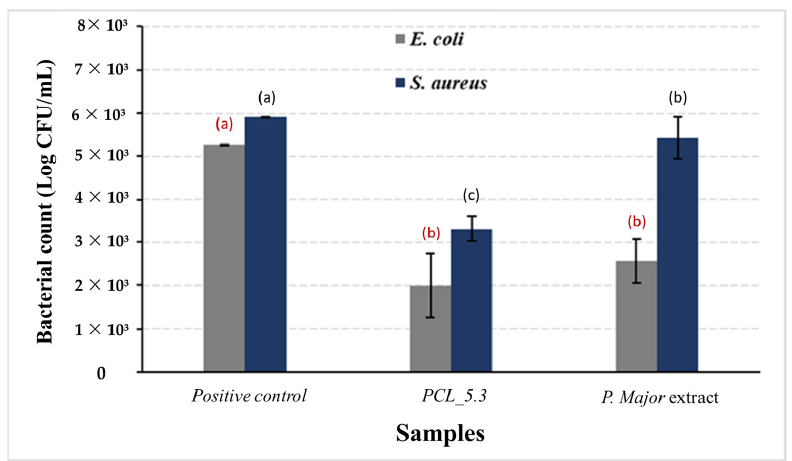
Figure 10. Antimicrobial activity of Plantago major hydroalcoholic extract and PCL/ P. major electrospun mat against E. coli and S. aureus strains. Pure PCL electrospun mat (PCL_0.0) was used as positive control (a,b,c Di ff erent le tt ers indicate statistically di ff erences (Kruskal–Wallis and Fisher’s test; p < 0.05).